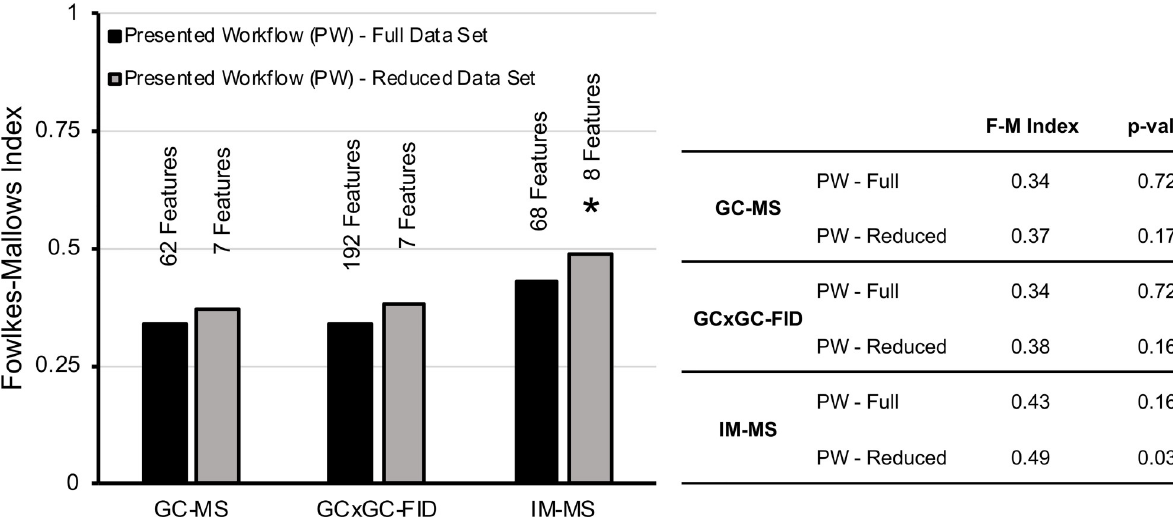
Fig 9. F-M index for the outcomes of clustering of Petroleum UVCB samples analyzed using 3 different techniques. � indicates that the results are statistically significant.